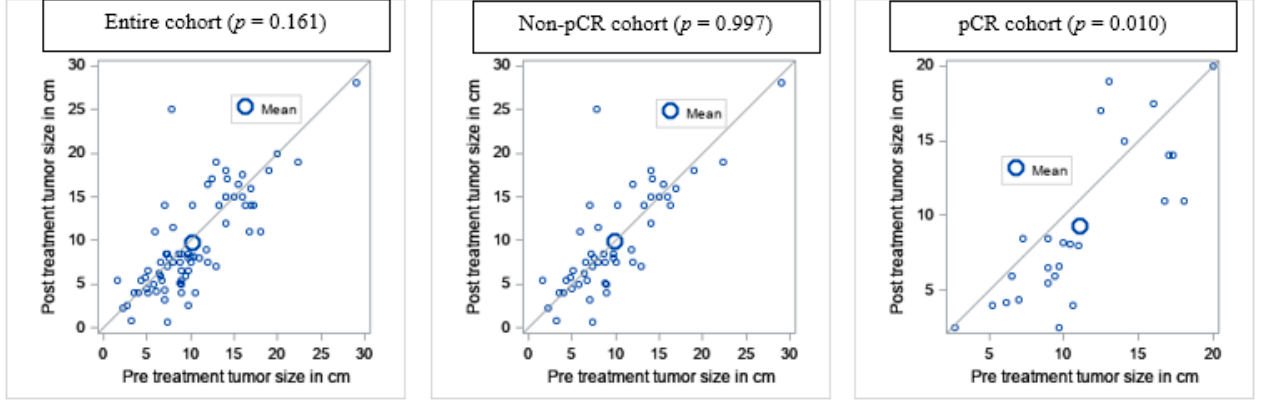
Figure 1. Comparing pre- and post-treatment tumor size in cm. Table 3. Logistic regression: Effect of treatment on pCR vs.